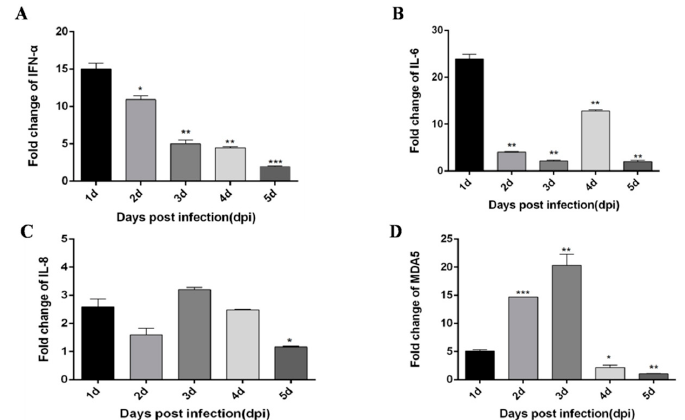
Figure 5. DTMUV-infected ducks effectively up-regulate IFN- α , IL-6, IL-8, MDA5 expression in the spleen. Each young SPF duck was challenged by intramuscular inoculation with DTMUV. ( A – D ) Spleen tissues of mock- and DTMUV-infected ducklings were collected at the indicated time points for examination of IFN- α ( A ), IL-6 ( B ), IL-8 ( C ), and MDA5 ( D ) mRNA expression using qRT-PCR. The average levels from three independent experiments are plotted. The error bars represent the SEs. * P < 0.05, ** P < 0.01. Figure 6. DTMUV-infected ducks effectively up-regulate MyD88, TLR2, TLR3 expression in the spleen. Each young SPF duck was challenged by intramuscular inoculation with DTMUV. ( A )–( C ) Spleen tissues of mock- and DTMUV-infected ducklings were collected at the indicated time points for examination of MyD88 ( A ), TLR2 ( B ), and TLR3 ( C ) mRNA expression using qRT-PCR. The average levels from three independent experiments are plotted. The error bars represent the SEs. * P < 0.05, ** P < 0.01.